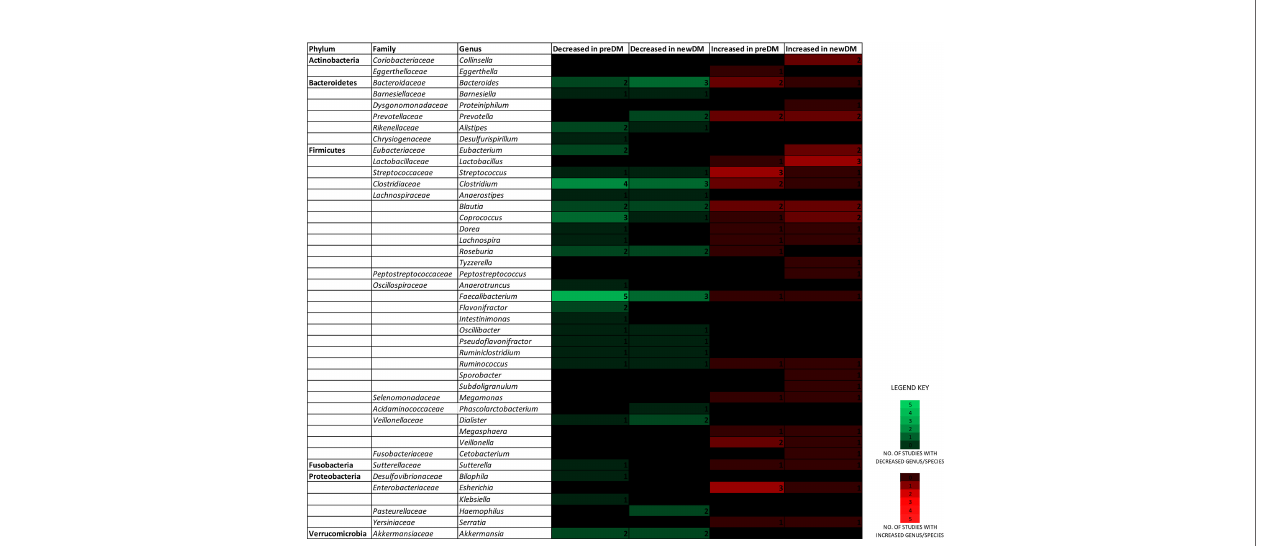
FIGURE 2 | A heatmap-like view depicting the genera/species of the six predominant gut microbial phyla, found to increase or decrease in the preDM and newDM groups, by number of reporting